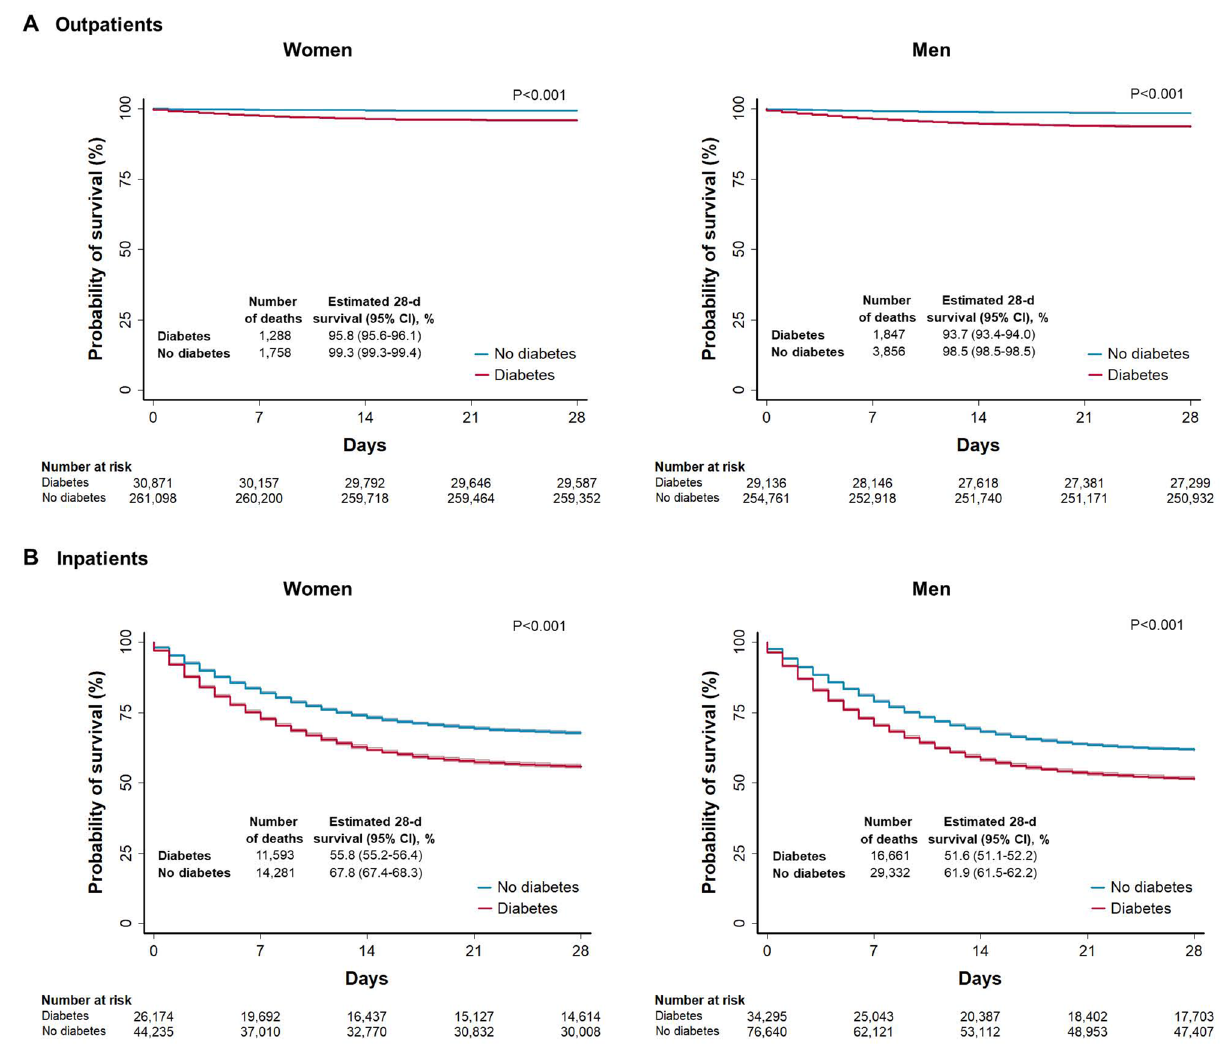
Figure 1. Unadjusted Kaplan–Meier survival curves among outpatients and inpatients with COVID-19 according to sex. Panels show the probability of survival according to sex among adult patients with and without diabetes who had COVID-19. Subjects were evaluated and notified from January 1 through October 7, 2020, and followed up for 28 days unless the event (death) occurred first. The solid lines represent survival probabilities and the shaded area represent the 95% confidence intervals